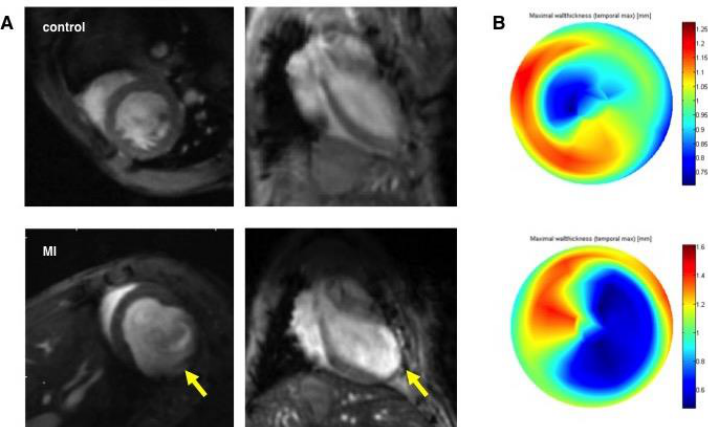
Figure 5. CMR images of representative healthy (upper row) and infarcted animals three weeks after MI (lower row) ( A ) left ventricular (LV) dilation, aneurysm formation in the thinned anteroseptal wall (yellow arrow) and LV hypertrophy can be observed. ( B ) bullseye plots depicting the maximal wall thickness of the left ventricle visualize the thinning of the apex and the anteroseptal wall.